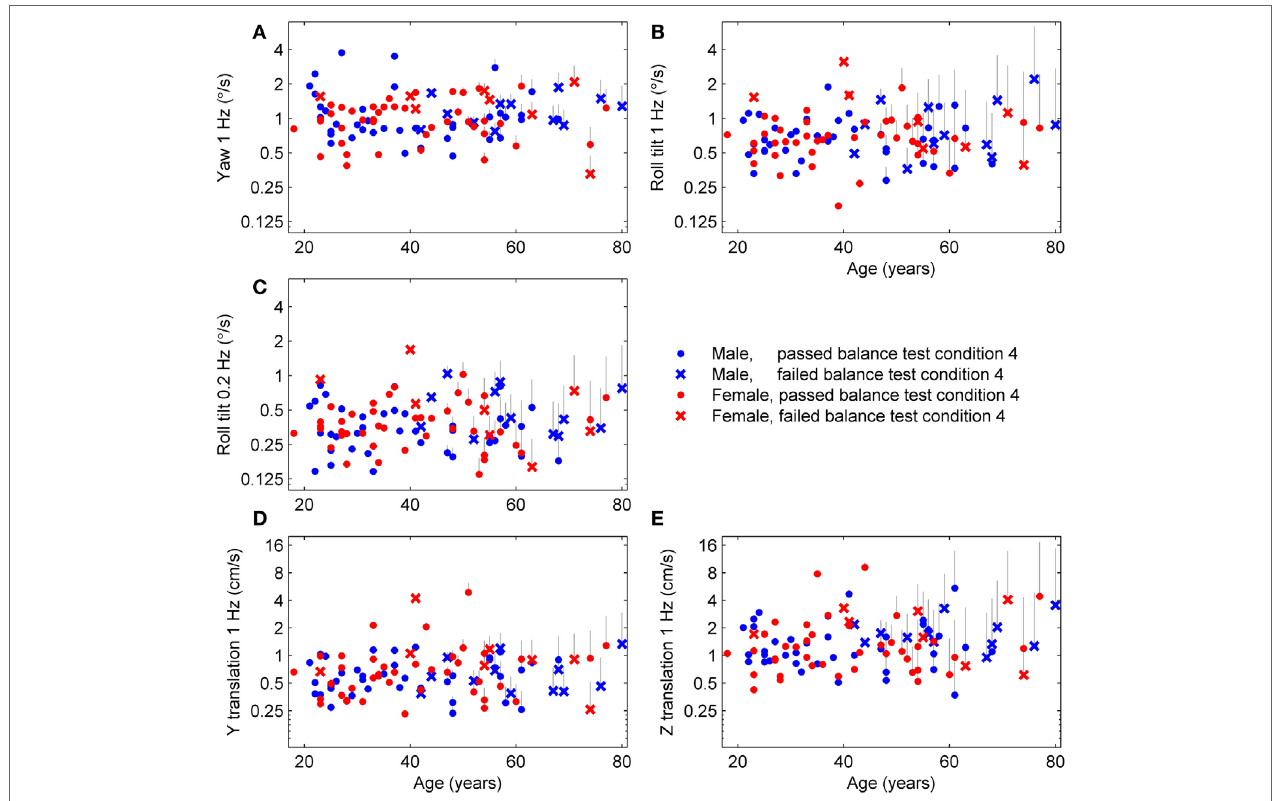
FigUre 1 | Age-adjusted thresholds for each subject and each of the five motion types. The published aging regression (1) found that thresholds had a constant baseline until 42.5 years, then increased at different rates for each of the five threshold measures. Thresholds for each subject above 42.5 years were adjusted to leave only variations independent of age. (a) The gray lines show the decrease in yaw threshold applied to each subject, with the top of the line showing the uncorrected threshold and the symbol at the bottom of the line showing the age-adjusted threshold. (B–e) Results for the four other threshold measures.